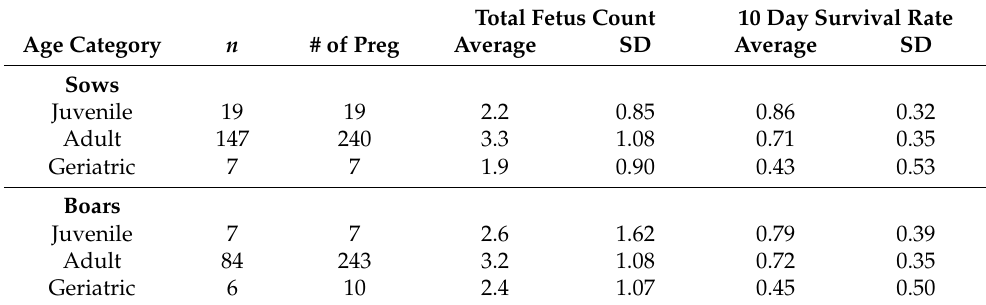
Table 1. Total fetus count and 10 day survival rate in strain 13/N guinea pig pregnancies by sow and boar age at delivery.